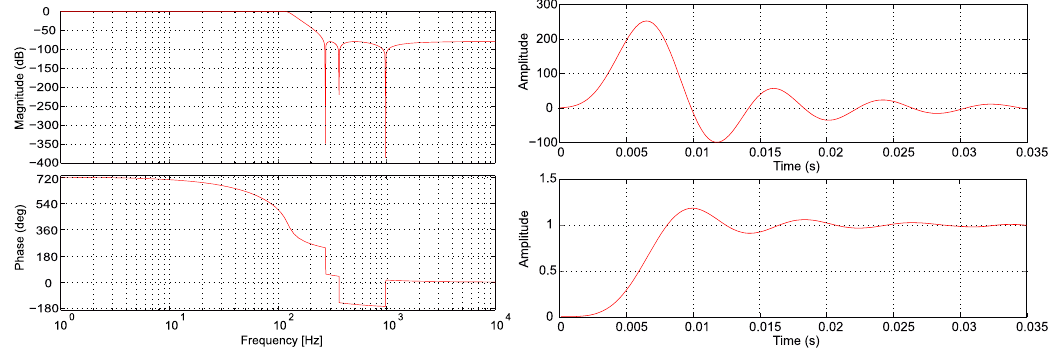
Figure 1. Filter prototype—frequency response and impulse/step response of sixth-order elliptic filter ω c 1 = 125 Hz.